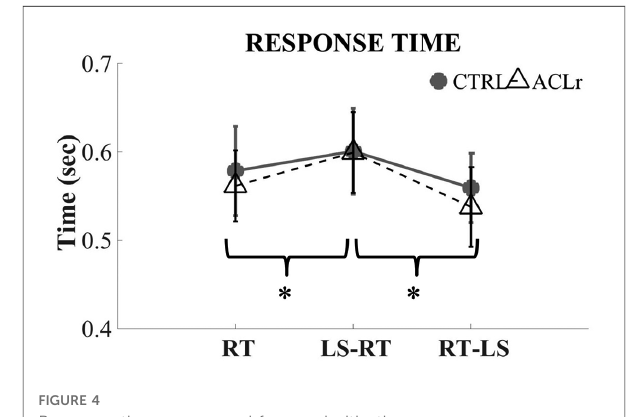
FIGURE 4 Response time groups and focus